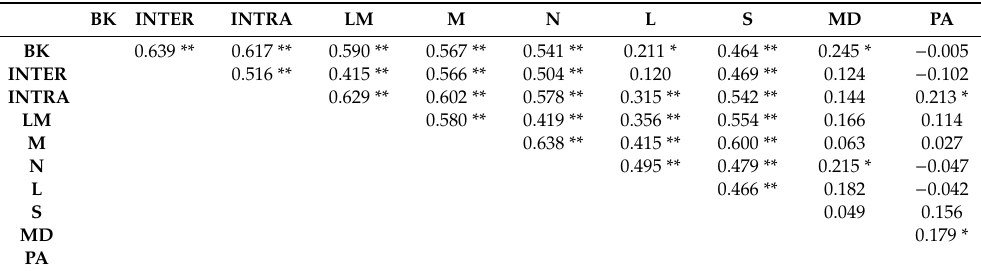
Table 3. Bivariate correlations between multiple intelligences, PA, and MD for males. BK